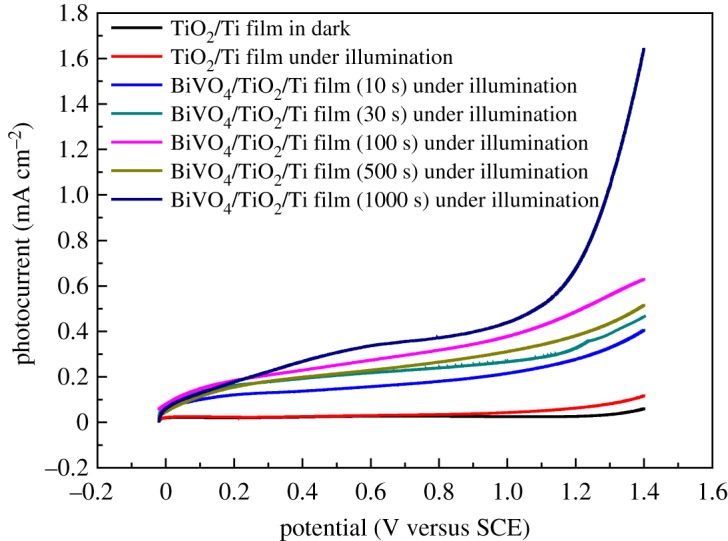
LSV plots of nanoporous TiO2/Ti film and nanoporous BiVO4/TiO2/Ti films prepared with different electrodeposition times in 0.2 M Na2SO4 solution under 150 W Xe lamp illumination.